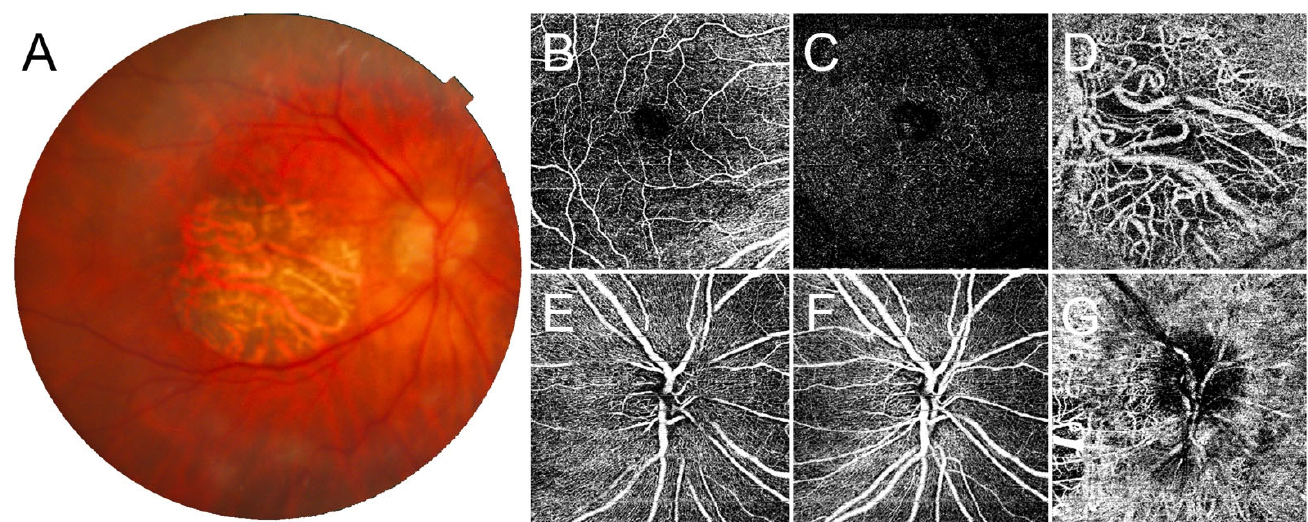
Figure 1. Optical coherence tomography angiography (OCTA) findings in CRB1 ‐ associated retinal dystrophy presenting with macular atrophy. Color fundus photography ( A ) shows complete atrophy of the macular region. Here, OCTA detects a partially spared superficial capillary plexus ( B ), markedly disrupted deep capillary plexus ( C ), and completely absent choriocapillaris ( D ) in the macula. At the level of the optic nerve head, it is possible to observe a loss of the radial peripapillary capillary plexus ( E ), together with a rarefied superficial and deep capillary plexus ( F ), while the choriocapillaris appears preserved ( G ).